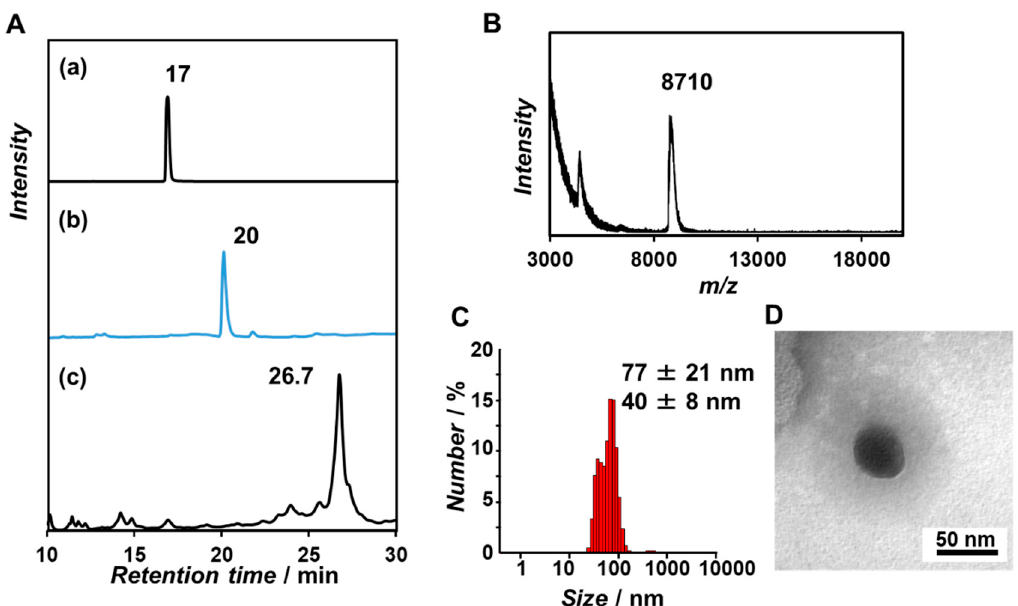
Figure 2. ( A ) Reverse-phase HPLC chart of ( a ) dT 20 -NH 2 , ( b ) PySS-dT 20 detected at 260 nm, eluted with a linear gradient of CH 3 CN / 0.1 M NH 4 HCO 2 aq (0 / 100 to 100 / 0 over 95 min), and ( c ) dT 20 -SS- β -annulus detected at 260 nm, eluted with a linear gradient of CH 3 CN / 0.1 M NH 4 HCO 2 aq (10 / 90 to 100 / 0 over 95 min). ( B ) MALDI-TOF-MS of the purified dT 20 -SS- β -annulus (matrix: 3-HPA). ( C , D ) TEM image and size distribution obtained from dynamic light scattering (DLS) for an aqueous solution of 50 µM dT 20 -SS- β -annulus in PBS (pH 7.4) at 25 °C.